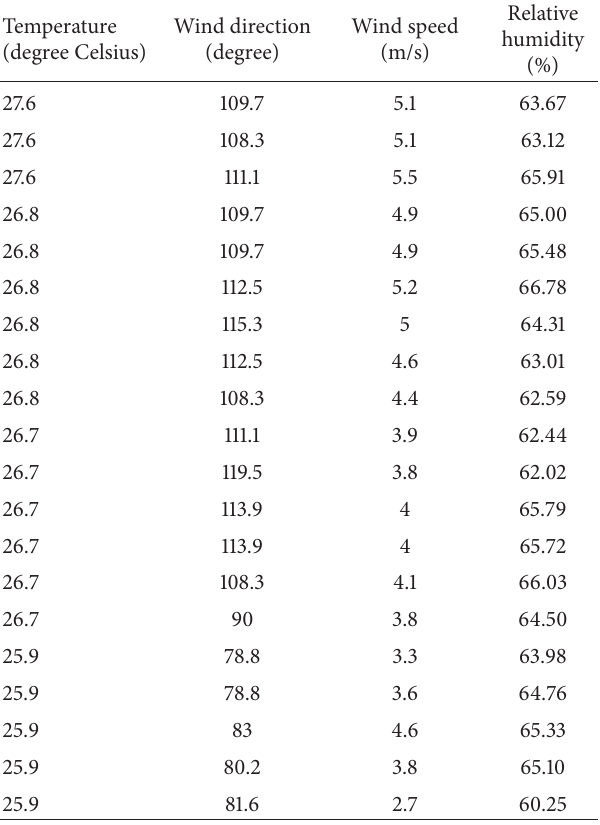
Table 2: Real time wind farm data samples (Suzlon Pvt. Ltd.).